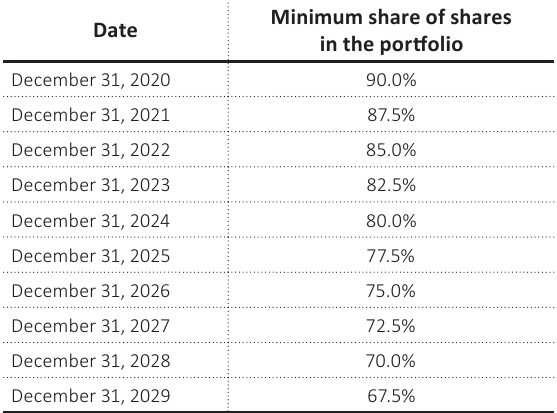
Table 3. Evolution of the share of shares in IRA portfolios after the liquidation of OPF